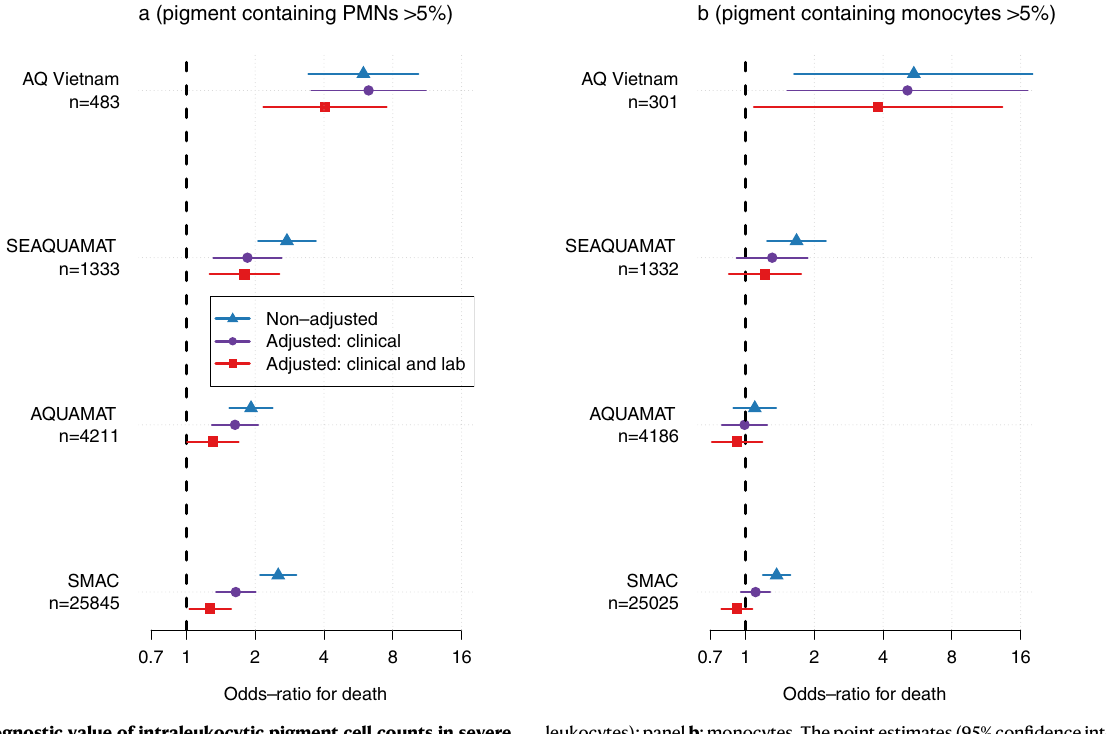
leukocytes);panel b :monocytes.Thepointestimates(95%con fi denceintervals)for thenonadjustedmodelsareshownbythebluetriangles(bluelines);forthemodels adjusted with clinical variables only are shown by the purple circles (purple lines); forthe models adjusted withclinicaland laboratory variables are shownbythe red squares (red